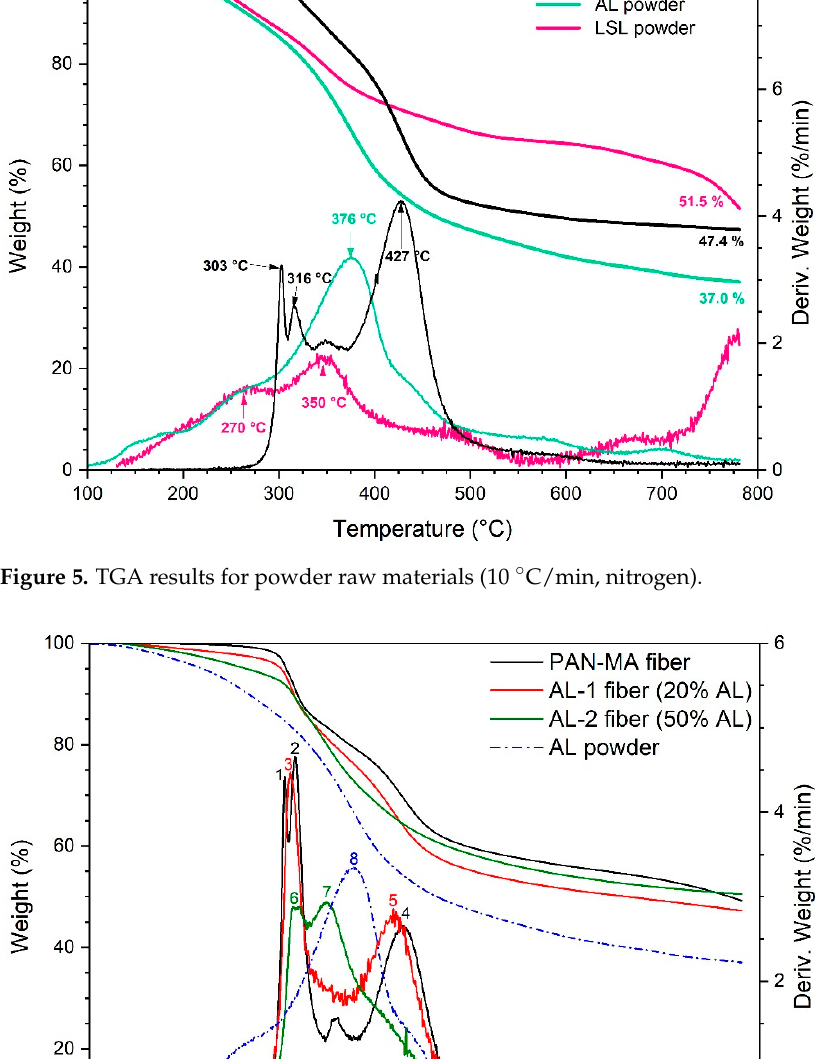
Figure 6. TGA results for AL-containing nanofibers as compared to pure PAN-MA fibers. Numbers denote points of discussion in the text.